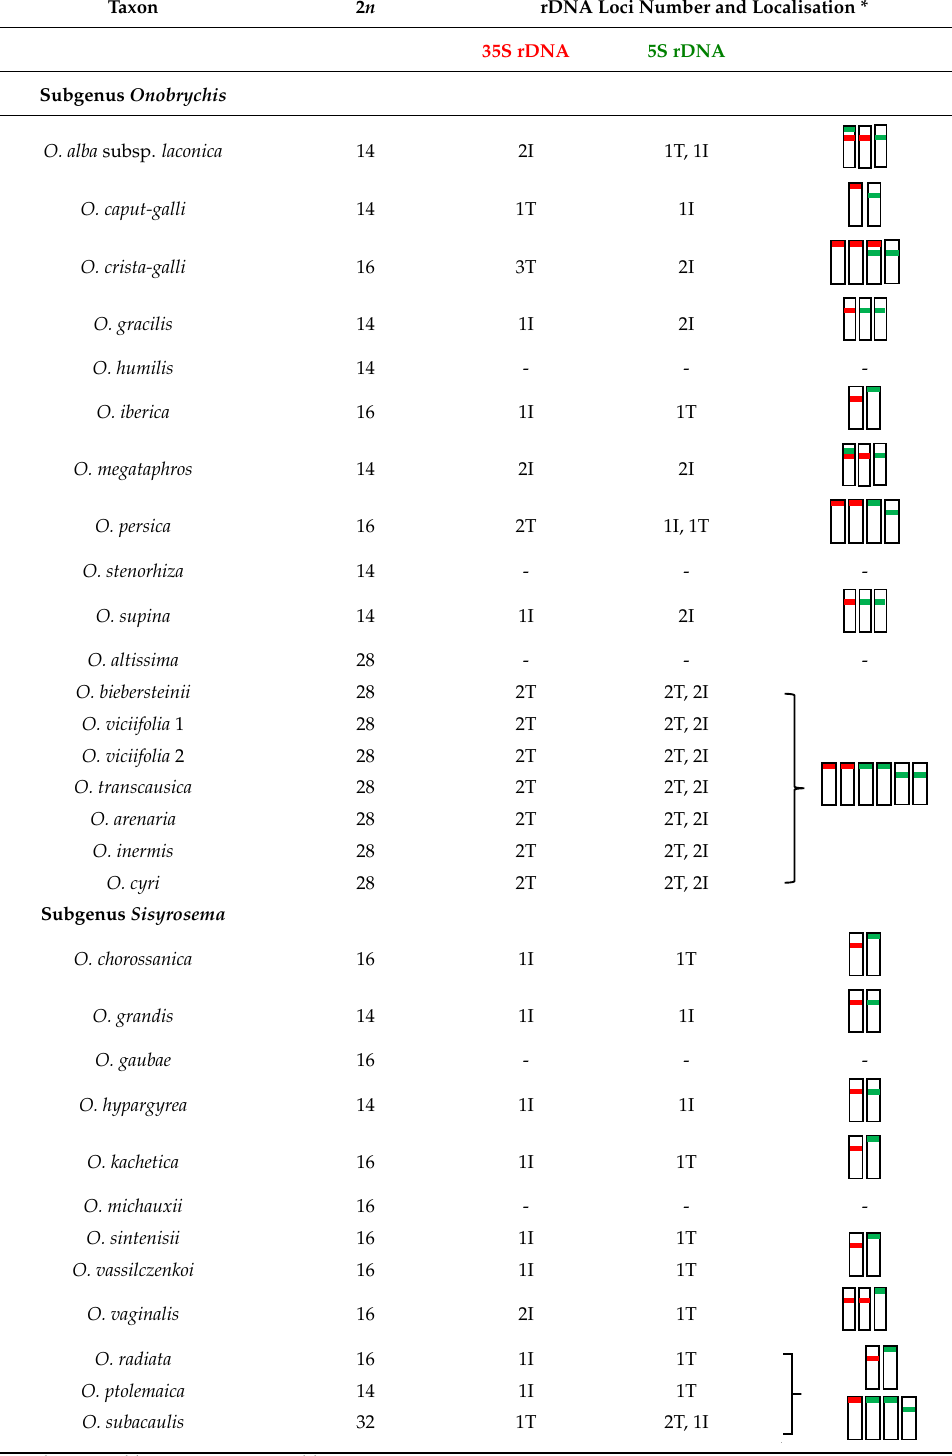
Figure 1. Chromosome number and distribution of rDNA loci in diploid and polyploid Onobrychis species. Fluorescence in situ hybridisation was performed with 5S rDNA probe (green fluorescence)